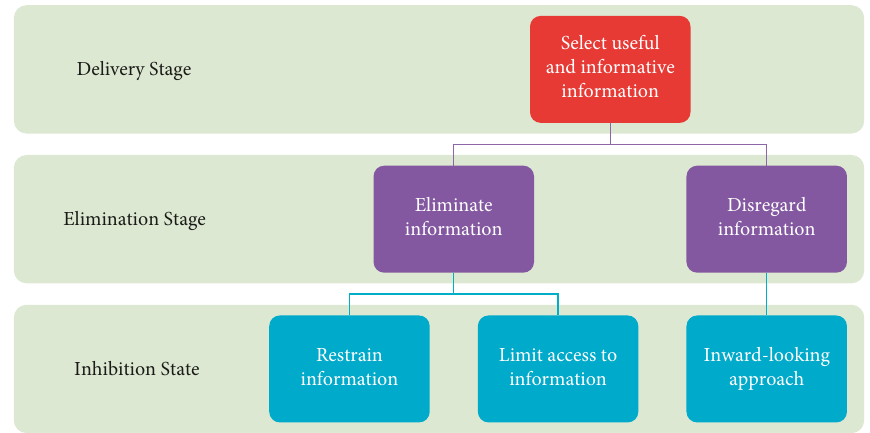
Figure 2: Internet information gatekeepers theory